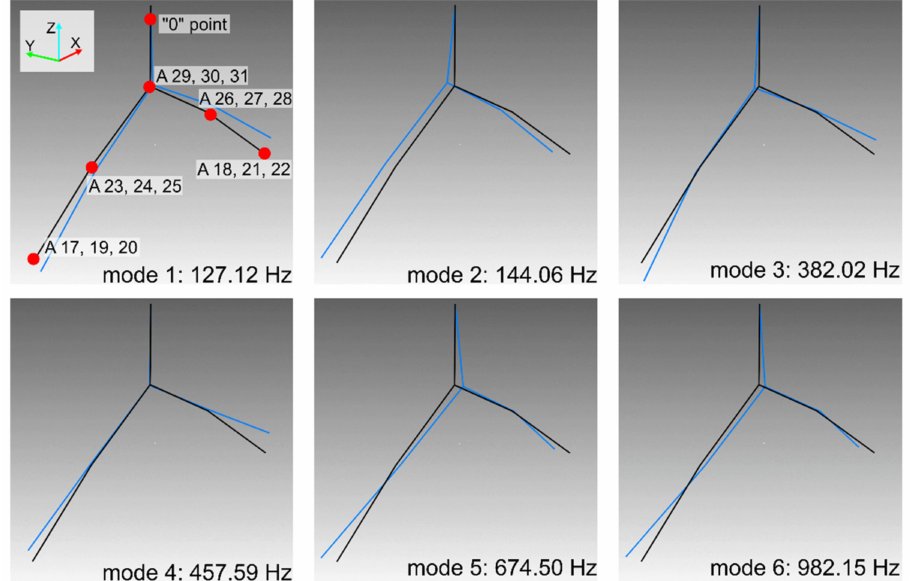
Figure 8. Normal modes of vibration of a boring tool determined by the p-LSCFD method. For the mode 1, sensor locations are